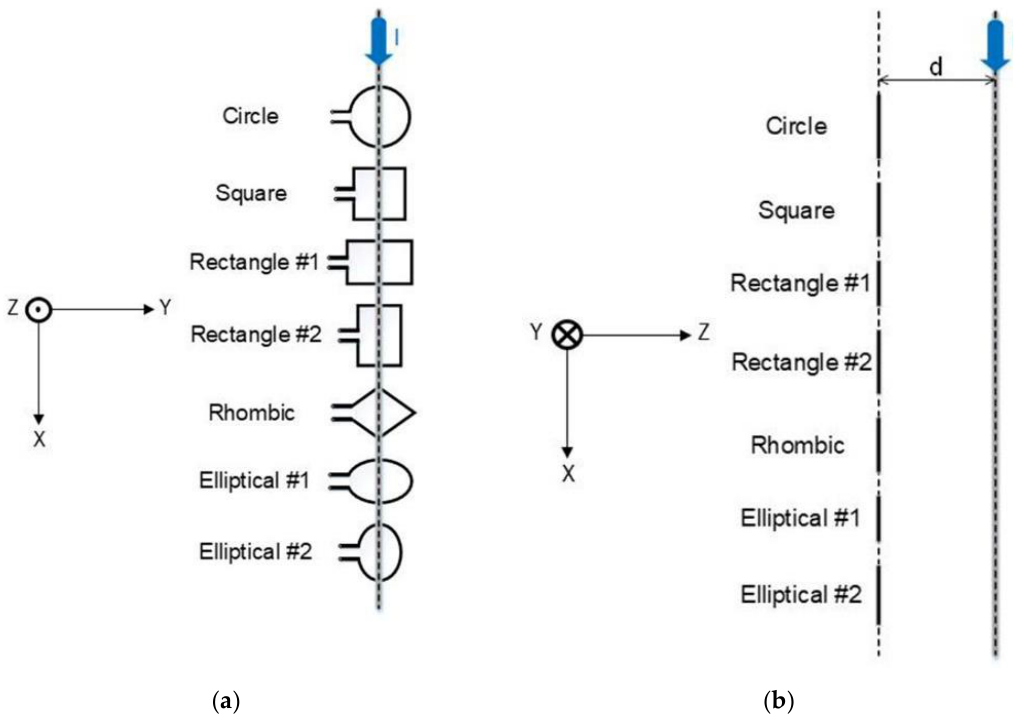
Figure 3. Simulation models of loop antennas: ( a ) top view and ( b ) side view.